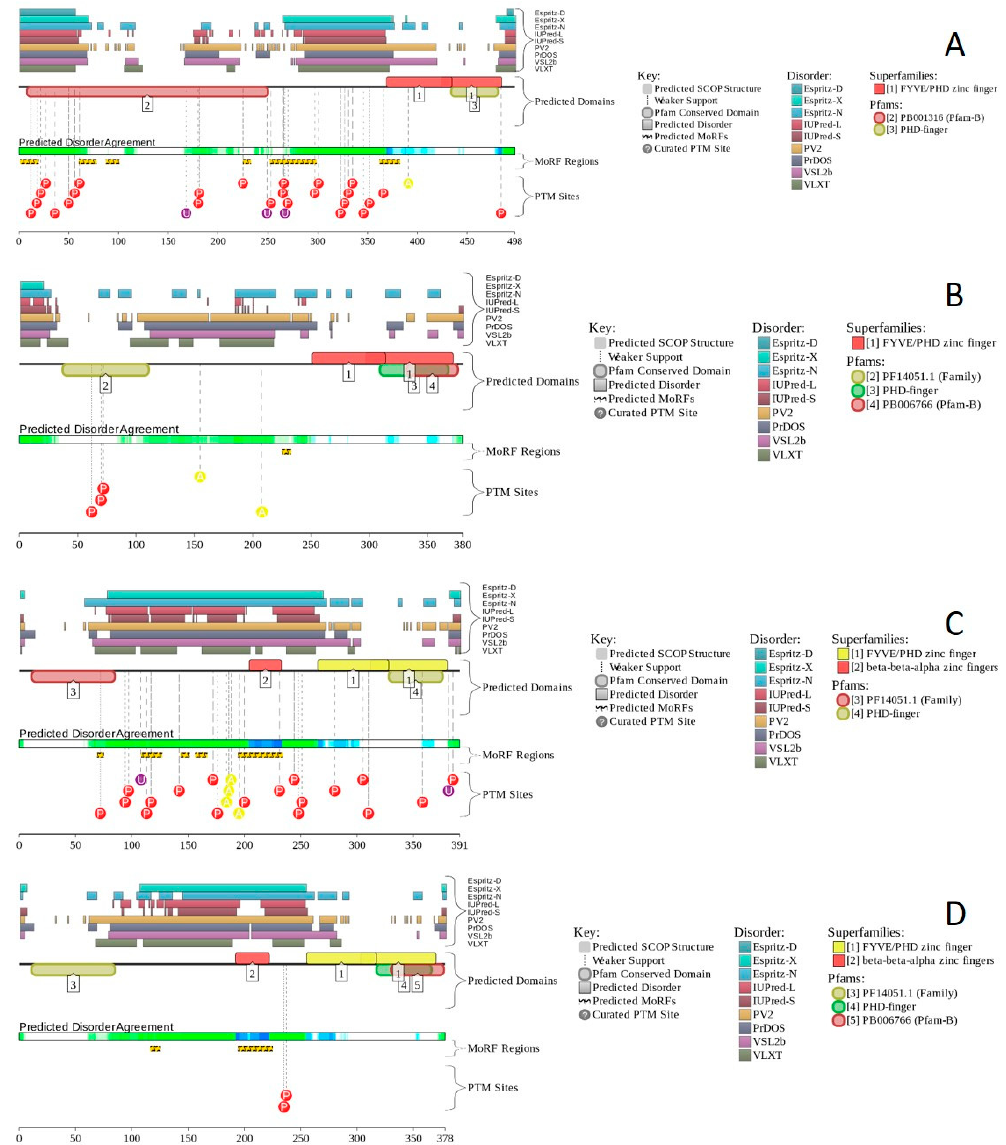
Figure 21. Structure, intrinsic disorder, and functionality of human BAF45A, BAF45B, BAF45C, and BAF45D proteins. ( A ) D 2 P 2 functional disorder profile of human PHF10 / BAF45A (UniProt ID: Q8WUB8). ( B ) D 2 P 2 functional disorder profile of human DPF1 / BAF45B (UniProt ID: Q92782). ( C ) D 2 P 2 functional disorder profile of human DPF2 / BAF45D (UniProt ID: Q92785). ( D ) D 2 P 2 functional disorder profile of human DPF3 / BAF45C (UniProt ID: